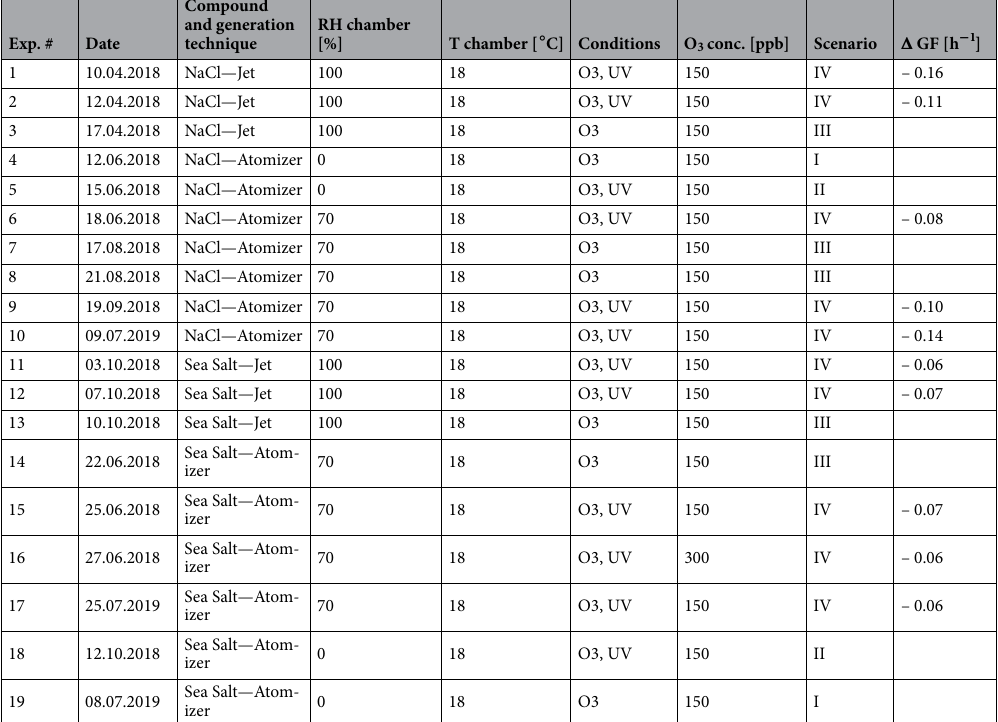
◦ C during all experiments, ◦ C.The GF(80%) decay rates ( (cid:31) GF) for particles